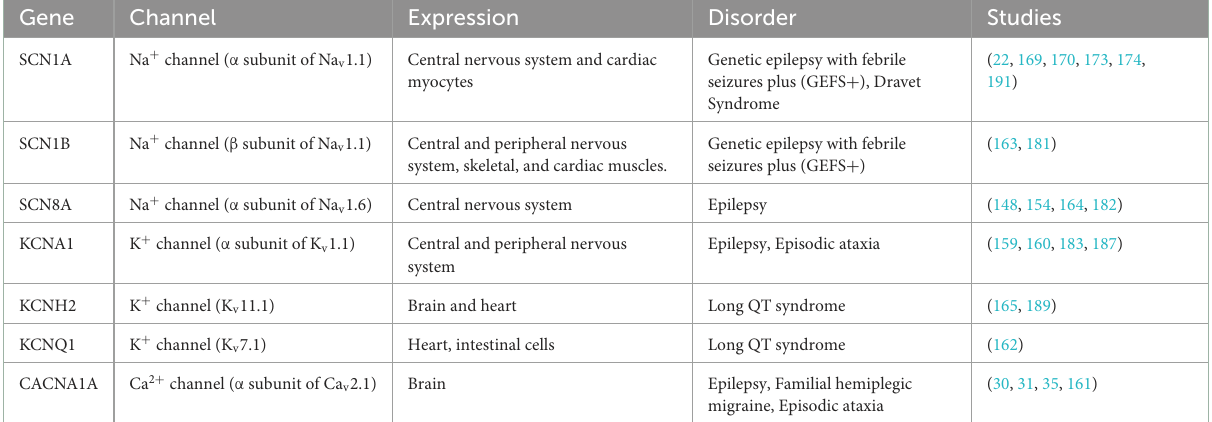
TABLE 1 Overview of common channelopathies in mouse models of epilepsy and SUDEP. Gene